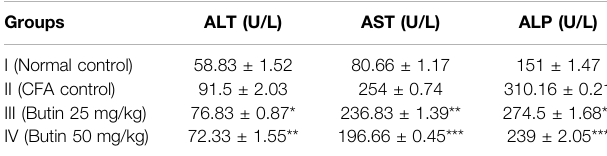
FIGURE 4 | Effect of butin on (A) RBC count, (B) WBC count, and (C) Hemoglobin levels in CFA-treated rats. Values are expressed in mean ± SEM ( n = 6). # p < 0.05 vs. normal control rats and ** p < 0.01 and *** p < 0.001 vs CFA control rats. One-way ANOVA followed by Tukey ’ s post hoc test.